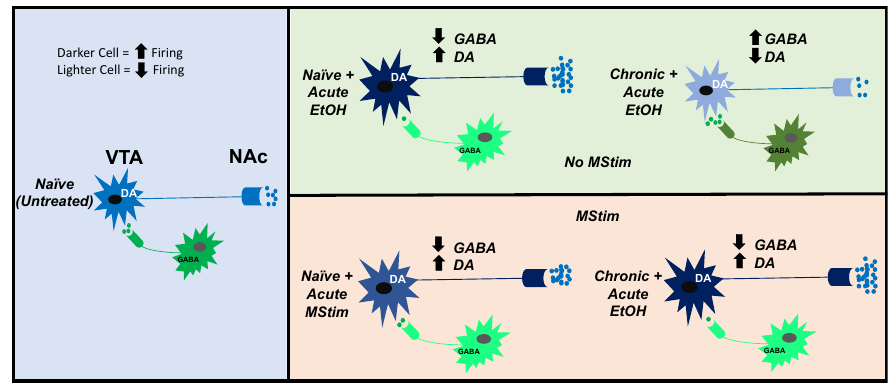
Figure 1. Proposed effects of MStim on VTA GABA and DA neuron firing rate and neurotransmitter release in the VTA and NAc compared between naïve state and acute EtOH exposure in the context of MStim and no MStim and chronic EtOH exposure and no chronic EtOH exposure.